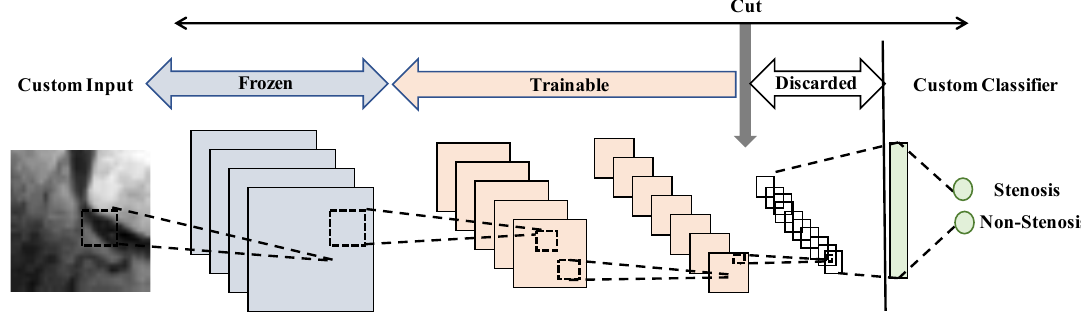
Figure 6. Outline of the fine-tuning stage and network cut methodology. The top-layers are